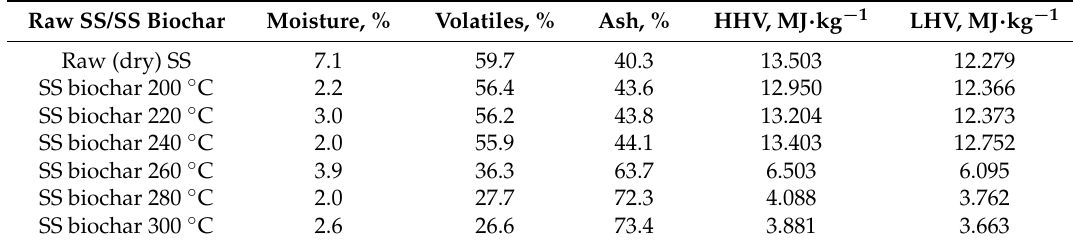
Table 5. Moisture, volatiles, ash content, HHV, and LHV of sewage sludge and torrefied sewage sludge biochars at different temperatures. Raw SS/SS